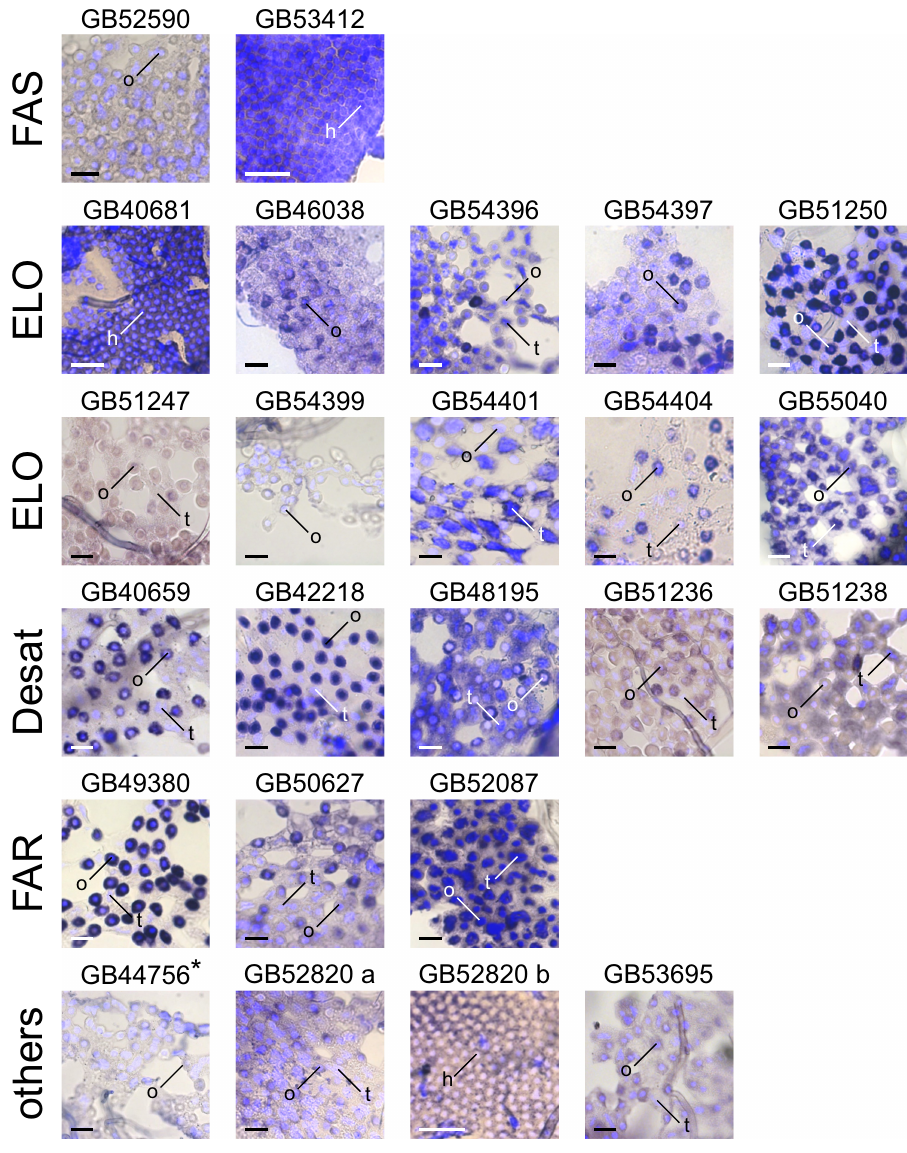
Fig. 4 Cell-speci fi c expression of candidate genes in the fat body of worker honey bee ( Apis mellifera ). The photomicrographs visualize the expression (dark blue/purple) of fatty acid synthases (FAS), fatty acid elongases (ELO), fatty acid desaturases (Desat), fatty acid reductases (FAR), and additional candidate gene transcripts (others) in fat body cells. Three fat body cell types are indicated: hexagonal cells (h), oenocytes (o), and trophocytes (t). Two separate photomicrographs visualize the expression of GB52820 . DAPI (in light blue) was used to counterstain nuclei. Staining in the photomicrograph for GB44756 (marked with an asterisk) did not signi fi cantly differ from that of the corresponding control (Supplementary Fig. 4). Scale bar: 50 μ